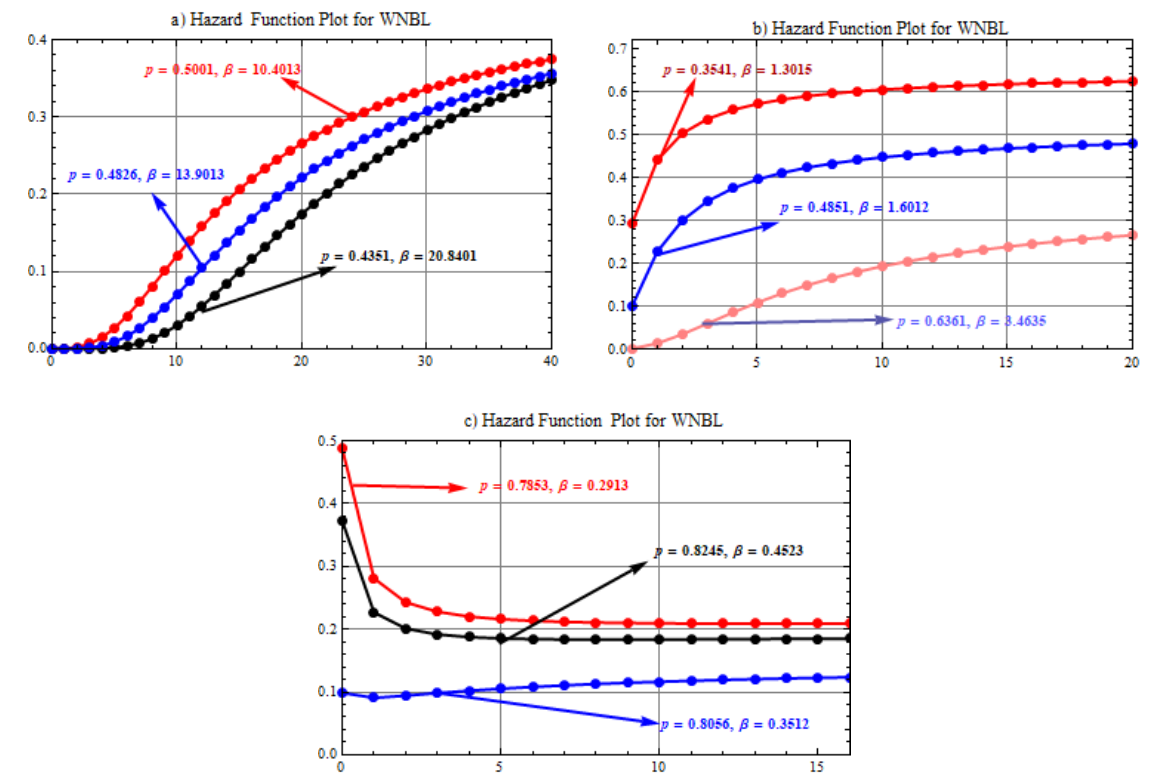
Figure 2 - Hazard Function Graphs for the Indicated Values of p and β of